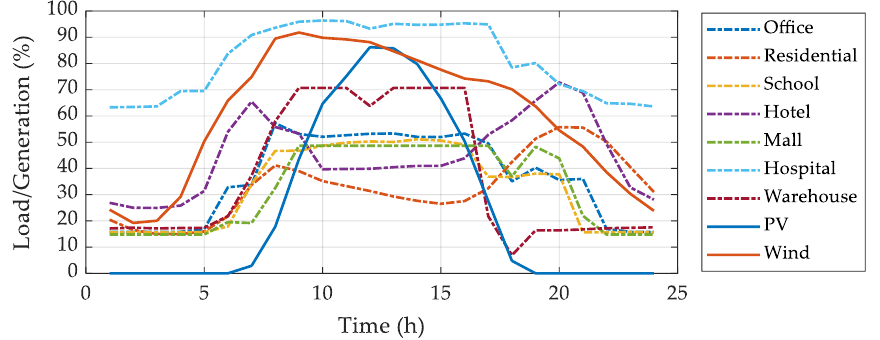
Figure 4. Load and generation curves for the selected day 29 th of